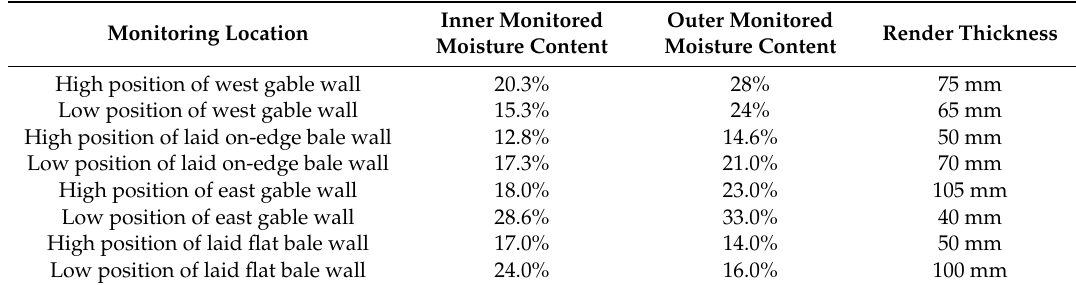
Figure 10. Degradation behind external render ( left ) and mixture of straw and lime render ( right ). Table 1. Rendering thickness of opening locations and measured moisture.